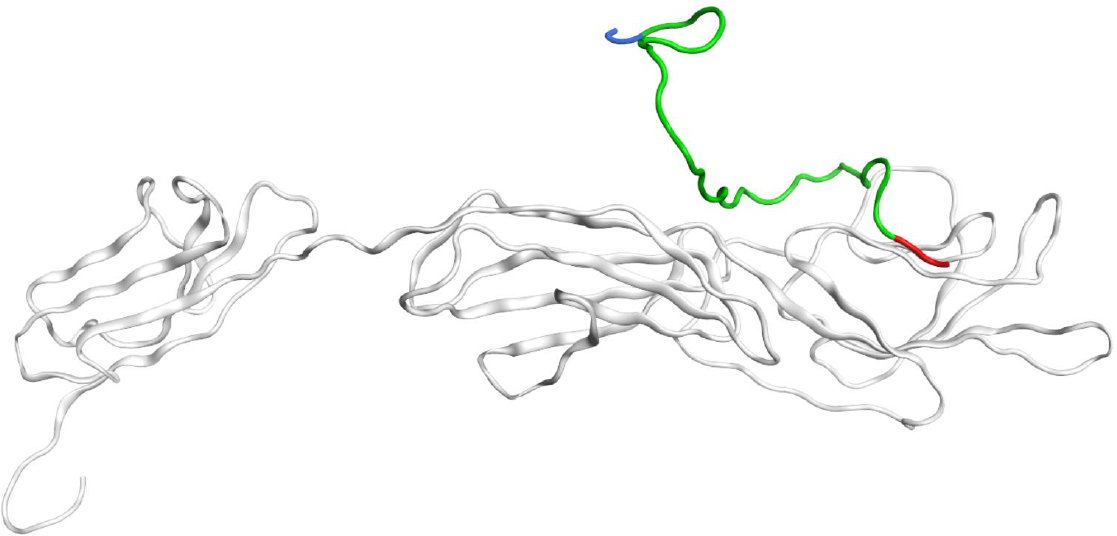
Figure 4. The resulting RAGE:Aβ 42 complex after 250 ns of MD at 5.5 pH. Aβ 42 is colored green, N-terminus is colored blue and C-terminus, red. The initial structure is shown in Figure 3A.